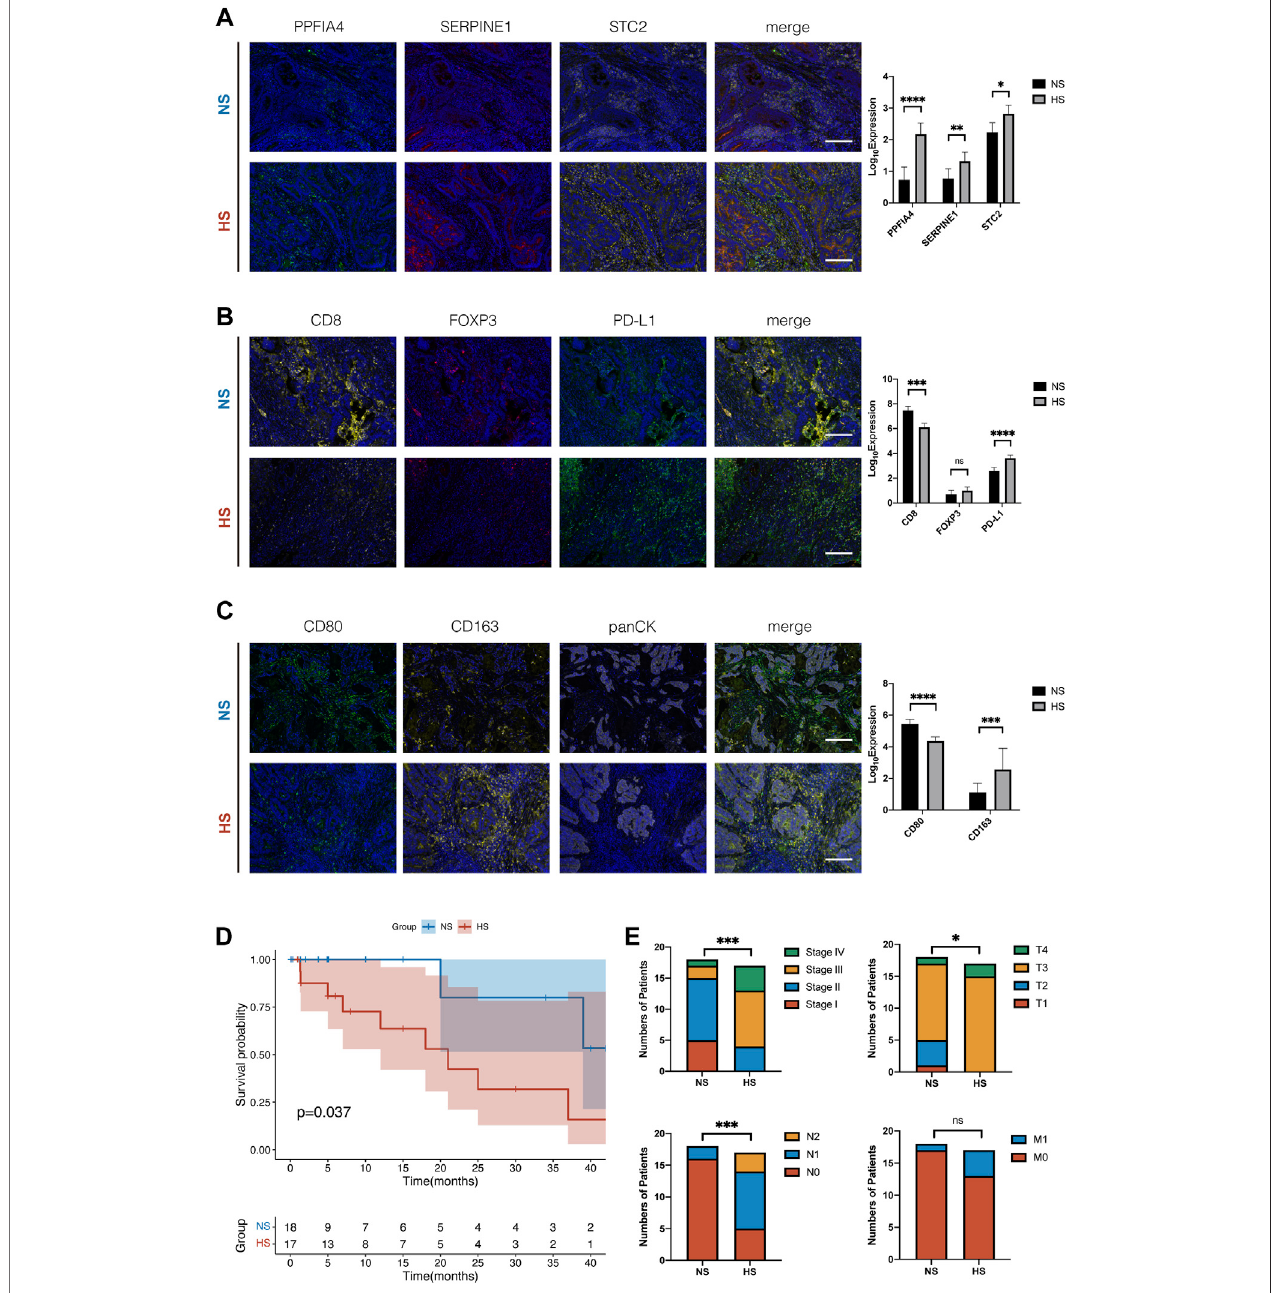
FIGURE 10 | Multiple immunohistochemistry staining of tissue samples from 35 colon cancer patients. (A) Typical fi gures of the expression of three hub hypoxia- relatedgenes,includingPPFIA4,SERPINE1,andSTC2,inNSandHS.Accordingtothemedianofexpression,wedivided35CCpatientsintoNSandHS.Thehistogram showed that the expression of three genes was signi fi cantly different, and three genes were positively related. (B) Compared with NS, HS had smaller colonization of CD8+ T cells and higher expression of PD-L1. But the number of Treg cells (FOXP3) had no statistical differences between subgroups. (C) The colonization of M1 macrophageswaslargerandM2macrophageswassmallerinNS,comparedwiththatinHS. (D) ThesurvivalplotofK-Manalysisofthe35coloncancerpatients. (E) The differences of the pathological features, including pathological stage (Stage), invasion depth (T), lymphocytic metastasis (N), and distant metastasis (M), of the 35 colon cancer patients. * represents p < 0.05, ** represents p < 0.01, *** represents p < 0.001, **** represents p < 0.0001.